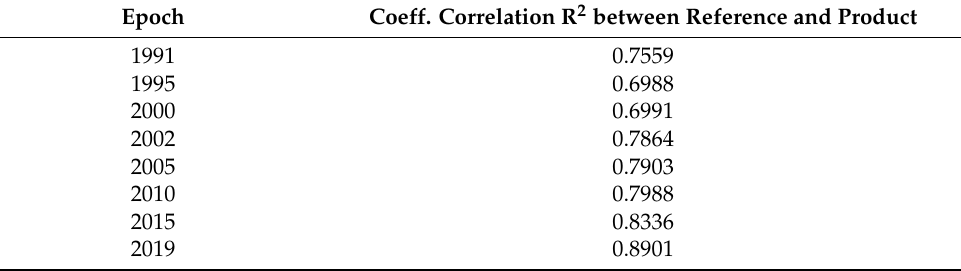
Table 3. Correlation between Forest Density value of reference data and map product.